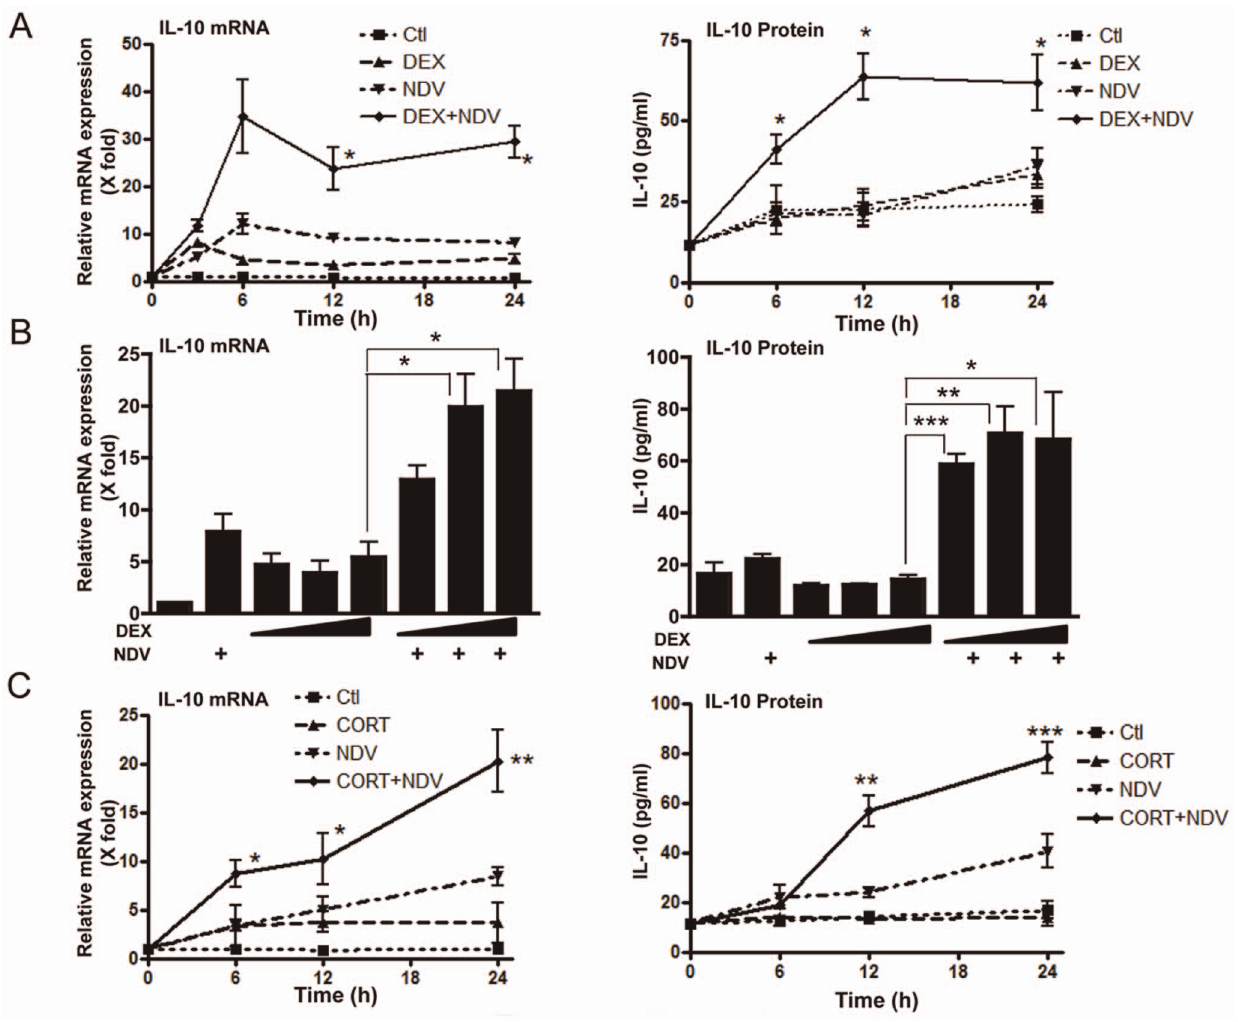
Figure 2. DEX pre-treatment and NDV infection cooperatively increased IL-10 mRNA and protein expression in DCs. DCs were pre- treated with DEX ( A : 10 2 6 M, B : 10 2 6 , 10 2 7 or 10 2 8 M) or CORT ( C : 10 2 6 M) for 30 min, and were infected with NDV (MOI=10) for 6 hours. Time- course of IL-10 mRNA ( A , left panel) and protein ( A , right panel) expression, and the effect of increasing concentrations of DEX on these parameters ( B , left and right panel, respectively) are shown. Time-courses of IL-10 mRNA (left panel) and protein (right panel) expression obtained in the presence of CORT pre-treatment are also shown in panel C . Relative IL-10 mRNA expression (fold changes) was calculated by comparing to the baseline (the conditions at time ‘‘0 0 or those obtained in the absence of DEX/CORT pre-treatment and NDV infection). Bars represent means and standard errors of fold changes of the IL-10 mRNA expression and protein concentrations in the culture media obtained from three independent experiments. *: p , 0.05, **: p , 0.01, ***: p , 0.001, compared to the conditions obtained in the presence of DEX or CORT treatment alone. Ctl: